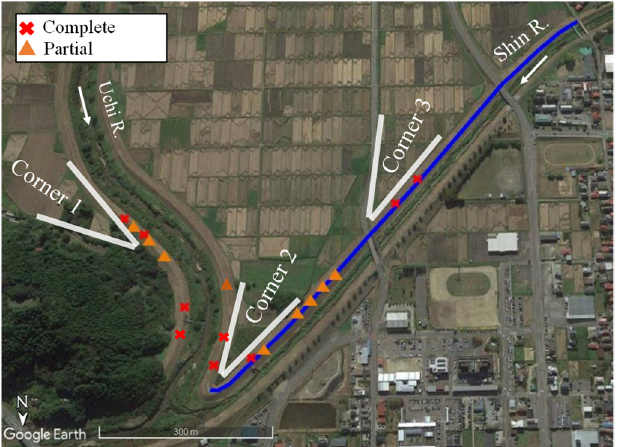
Figure 14. Levee damages at the constricted corners.